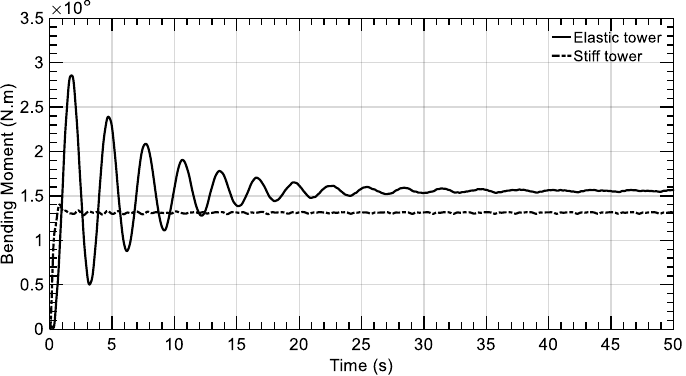
Figure 18. Tower-base fore-aft bending moment: stiff vs. elastic tower.